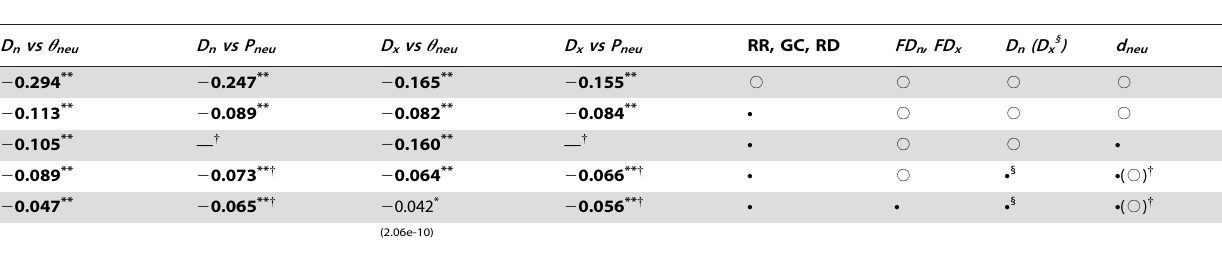
1 Correlation coefficients for D n versus h neu or P neu were calculated controlling for D x and the correlation coefficients for D x versus h neu or P neu were calculated controlling for D n . { Correlation coefficients for D n or D x versus P neu were not calculated or were calculated without controlling for d neu , as P neu (= h neu / d neu ) is not independent of d neu . ** P , 1e-10. * 1e-10 # P , 1e-3. NS P . =1e-3. Closed circles ( N ) indicate the controlled variables. Highly significant values (P , 1e-10) are in bold. P -values are given in parentheses for marginally significant (1e- 10 # P , 1e-3)